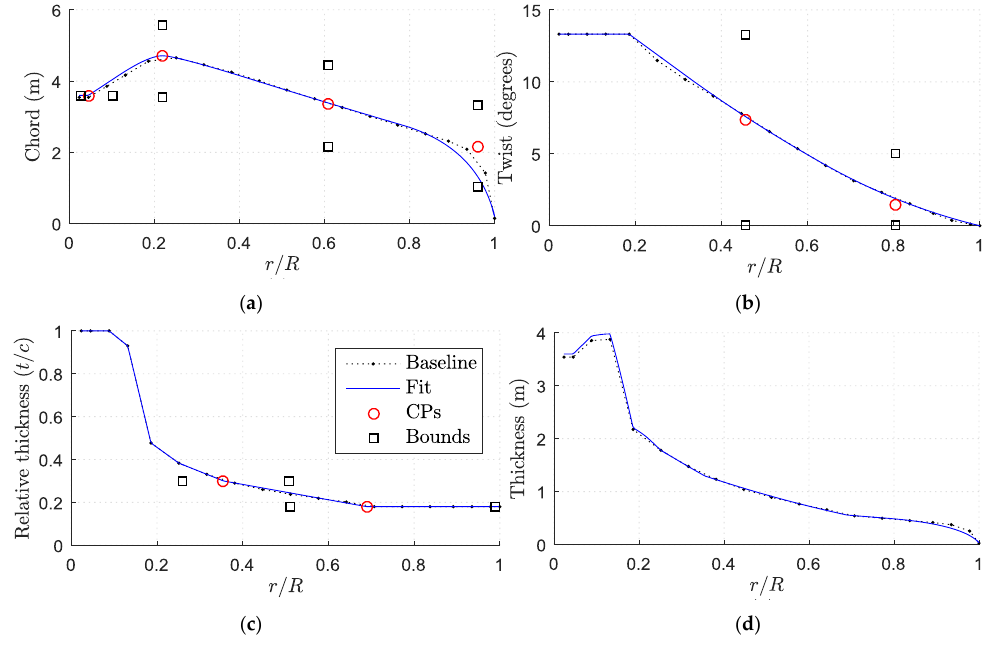
Figure 2. ( a ) Chord; ( b ) twist; ( c ) relative thickness; and ( d ) thickness fitted to the NREL 5 MW baseline wind turbine [30], where r / R is the normalized blade radius.